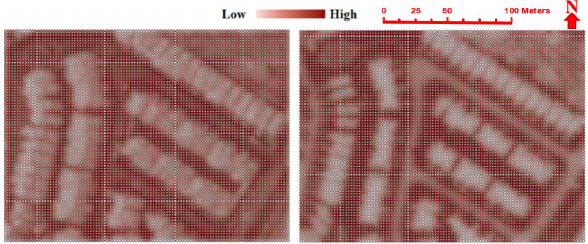
Figure 5. Maximun moment - aerial and LiDAR images (200 cm)